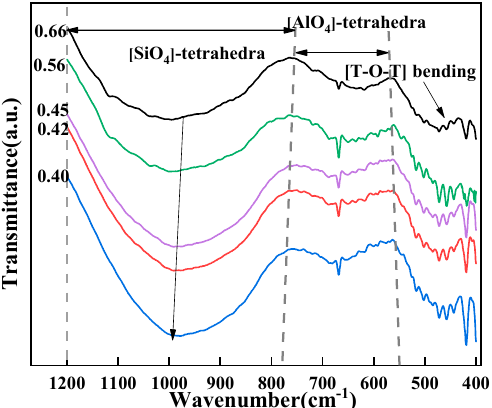
Figure 9. Effect of different MgO/Al 2 O 3 ratios on slag structure.